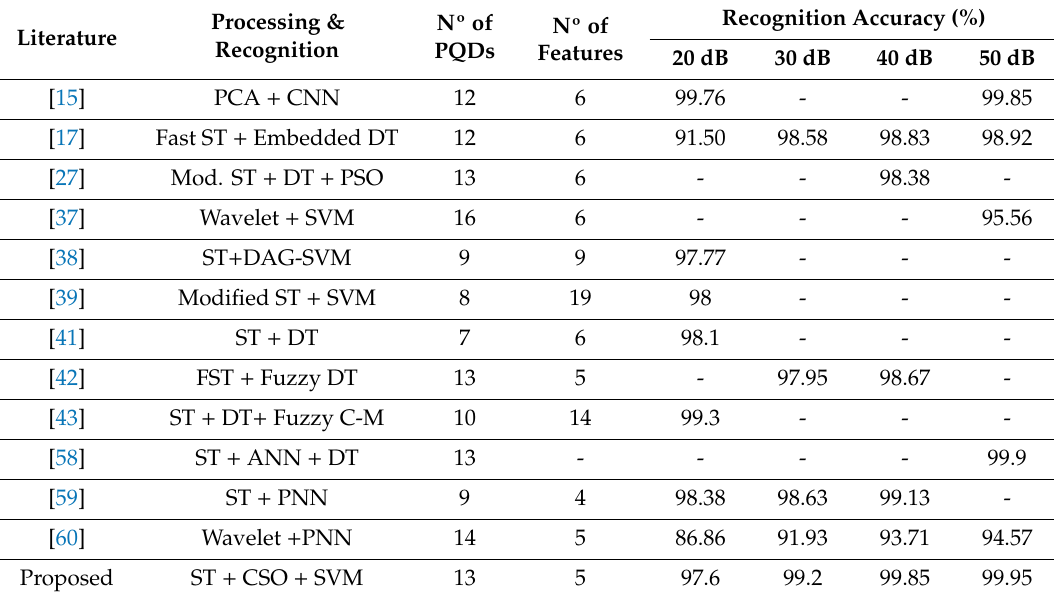
Table 5. Performance comparison of di ff erent